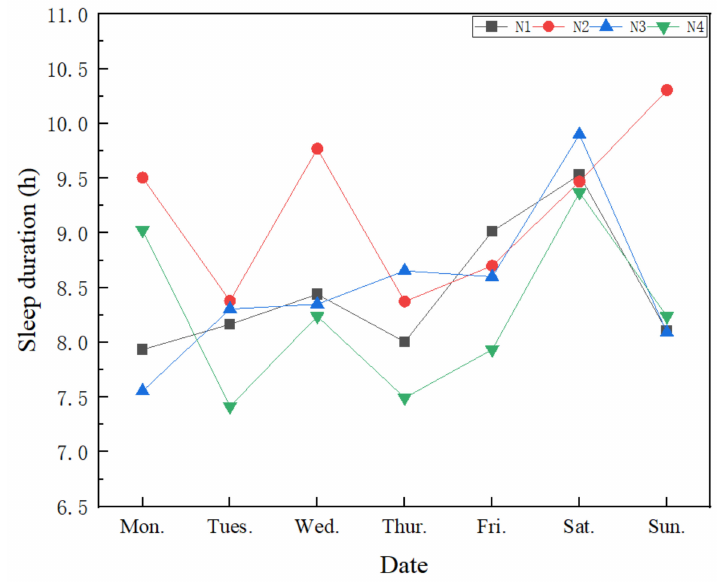
Figure 22. Sleep duration